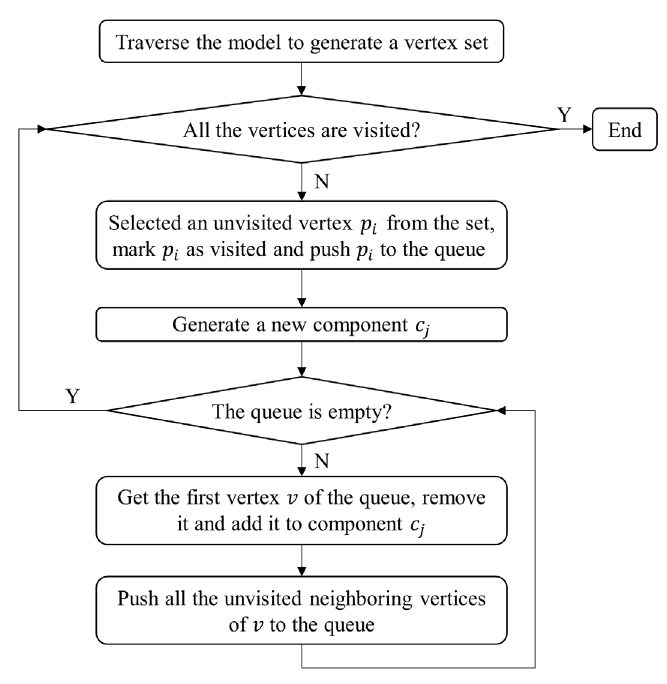
Figure 3. Flowchart of segmentation for building models.